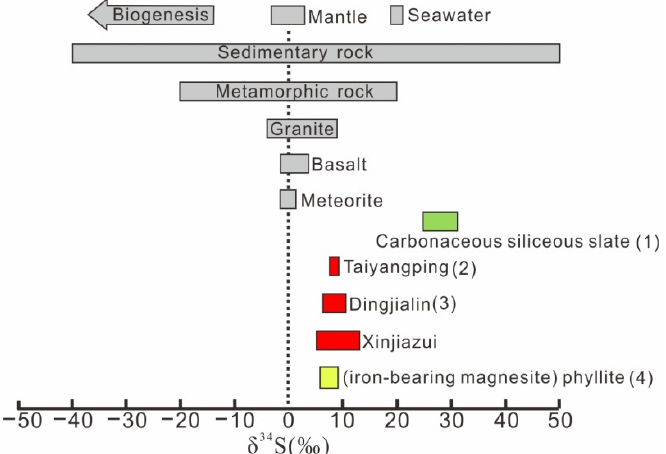
Figure 8. Box-plots of δ 34 S values of ore-forming pyrites from the Xinjiazui, Taiyangping, and Dingjialin gold deposits. Base map modified after Zheng et al. (2000) [58]; data sources of pyrite δ 34 S values for Carbonaceous siliceous slate are from Zuo (2020) [53]; those for Taiyangping deposit and phyllite are both from Wei (2008) and Zhong (2012) [38,39]; those for Dingjialin deposit are from Wei (2008) [38].